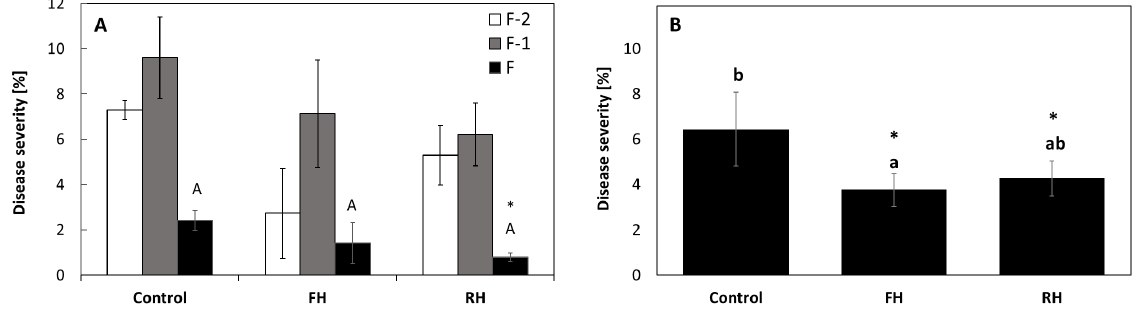
Fig. 4. Effect of repeated hydrolysate treatment on disease severity of the spot form of the net blotch of barley ( Pyrenophora teres maculata ) in the field experiment assessed at growth stage BBCH73. Treatments: FH, chicken feather hydrolysate; RH, reference hydrolysate; applied on BBCH31 and BBCH61. A: Disease severity in different leaf layers. B. Disease severity averaged over leaf layer. There was a significant effect of hydrolysate treatment ( p = 0.022) and leaf layer ( p < 0.001) on disease severity, but also significant effects of block ( p < 0.001) and sampling spot within block ( p = 0.044). Different letters indicate a significant difference according to Tukey HSD test at p < 0.05. Asterisks indicate a significant difference to the control according to Dunnett’s test at p <